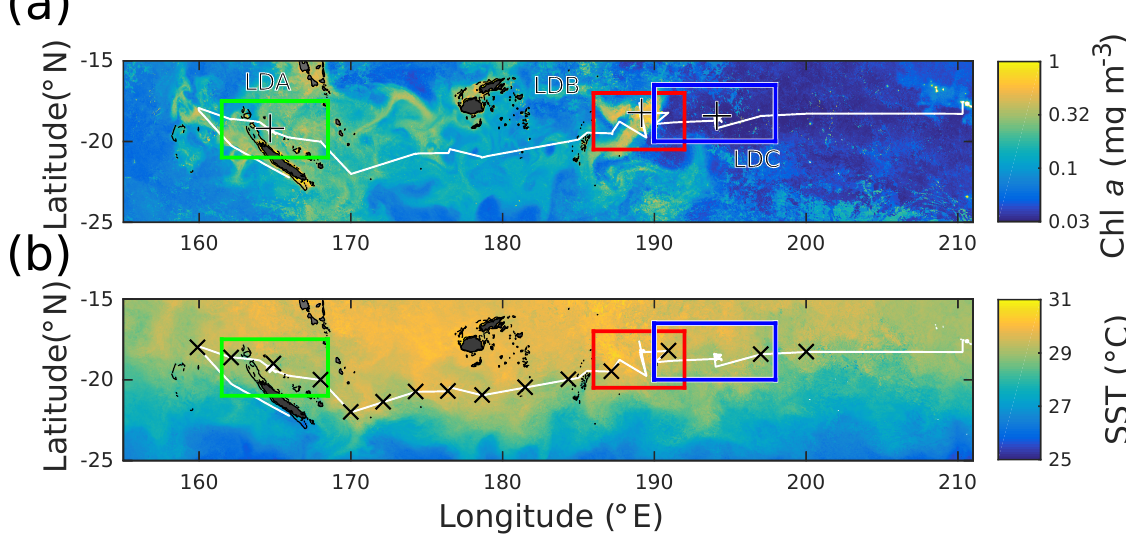
Figure 1. Satellite surface (a) chl a and (b) SST for the OUTPACE cruise. Pixel data are weighted by the normalized inverse distance squared between each pixel and the RV L’Atalante ’s daily position over the 42 days of OUTPACE. Ship track shown in white. LD station locations shown with black + ’s. Domains used in Fig. 2 are shown by color-coded rectangles, with green for LDA, red for LDB, and blue for